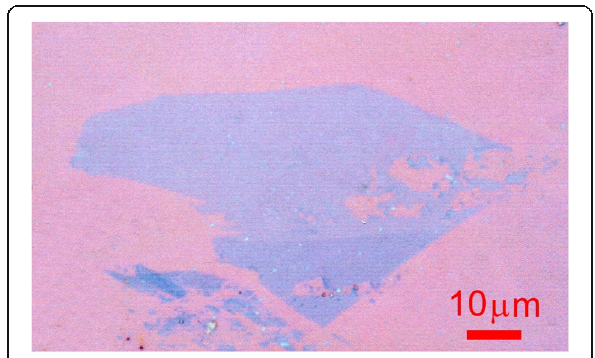
Fig. 1 Graphene sample. Optical microscopy image of the investigated graphene sample located on Si substrate, covered with 300-nm-thick SiO 2 layer